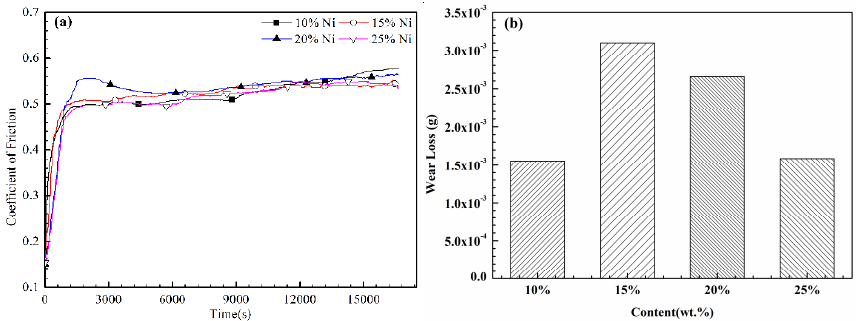
Figure 10. Influence of Ni content on ( a ) coefficient of friction and ( b ) wear lossof the coatings.